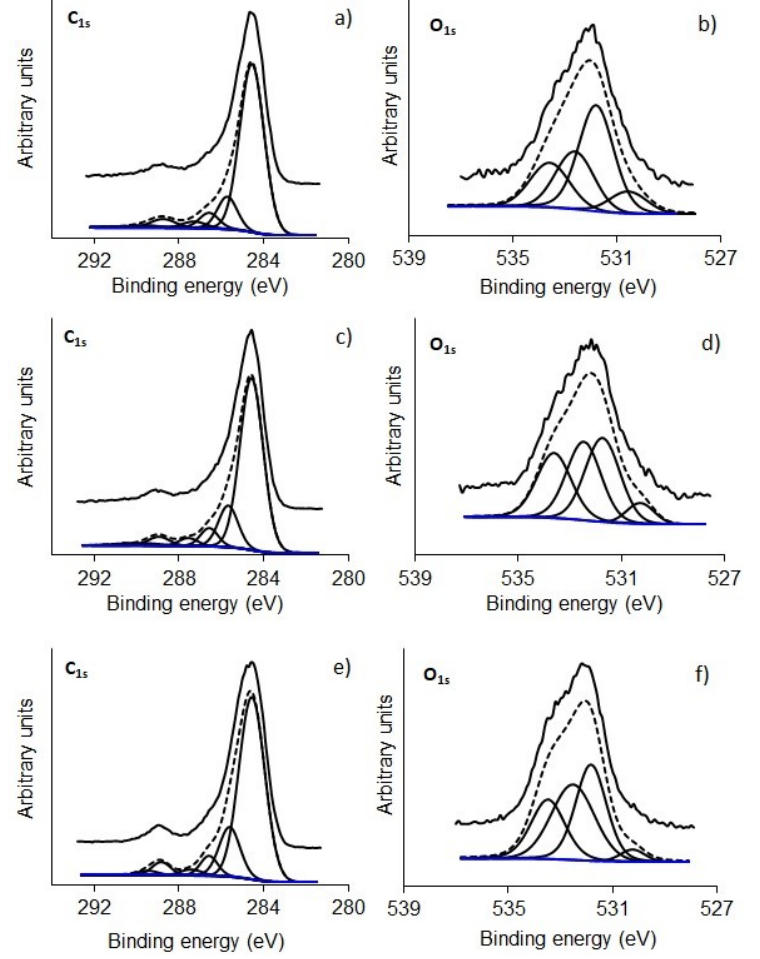
Figure 7. XPS high-resolution spectra of ( a ) C 1s and ( b ) O 1s regions for K600, ( c ) C 1s and ( d ) O 1s , regions for K700 and ( e ) C 1s and ( f ) O 1s regions for